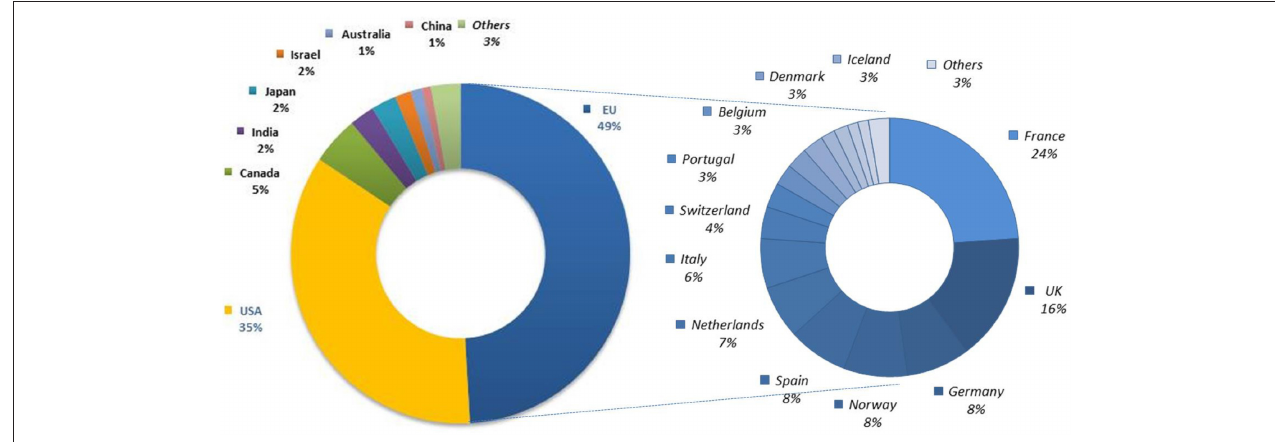
FIGURE 2 | The geographical distribution of the sample (world and EU; n = 460